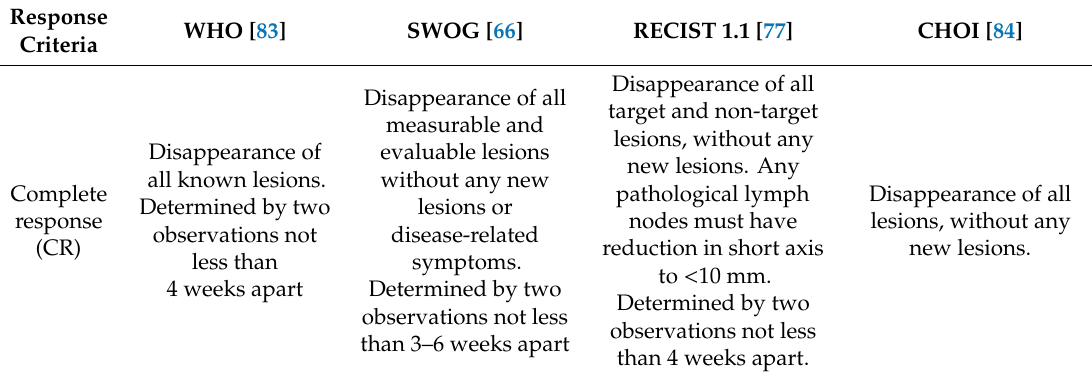
Table 3. Main radiological response criteria in solid